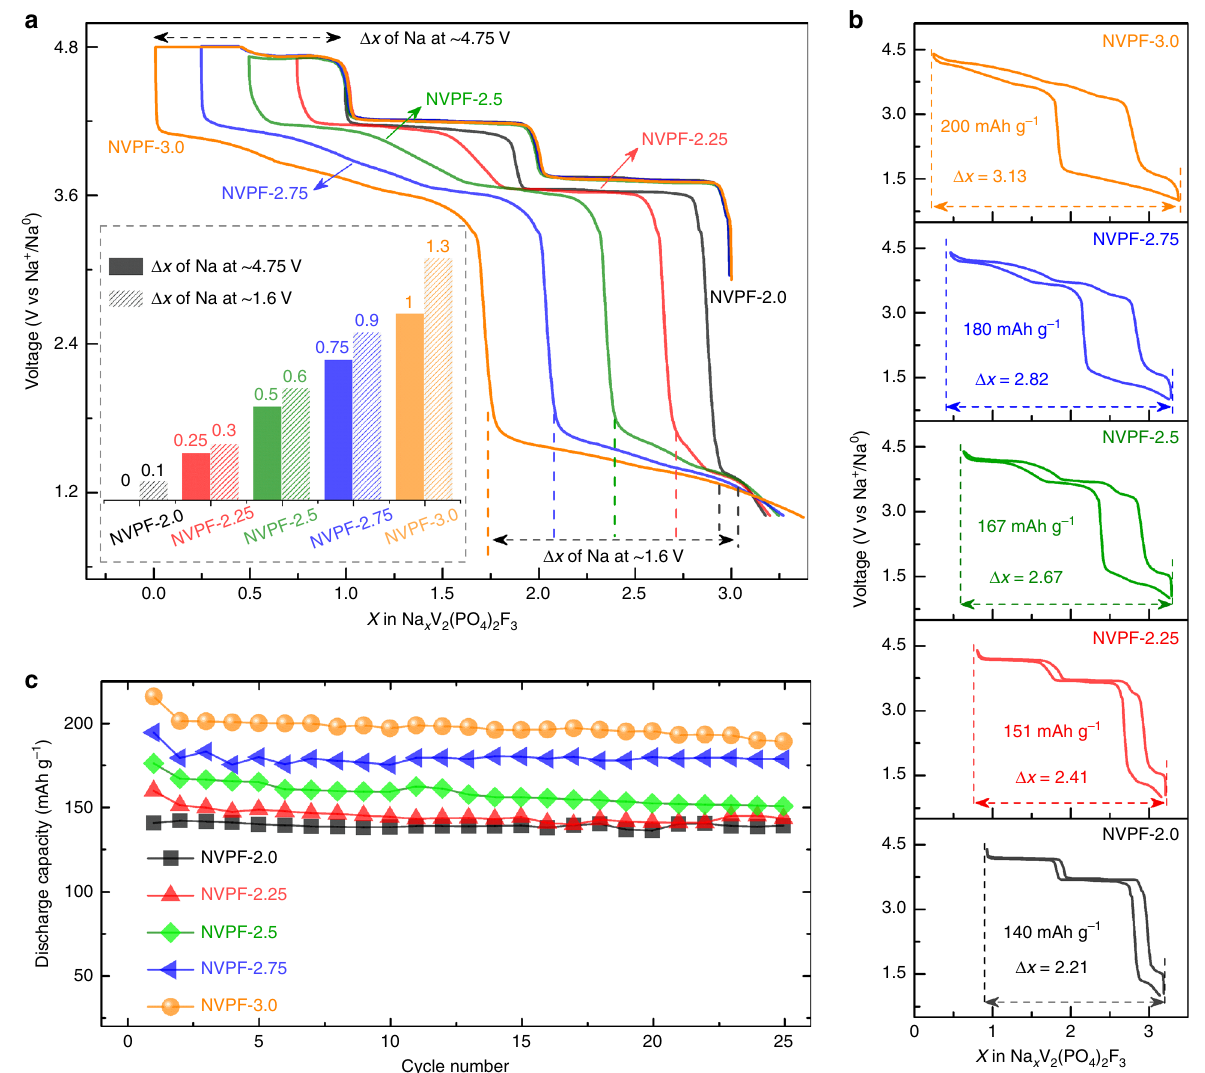
Fig. 2 Electrochemical characterization of NVPF samples in NVPF/Na half cells cycled between 4.4 and 1.0 V. a First cycle activation in which the charging potential is used up to 4.8 V and charge process controlled by limiting the Δ x (Na) = 2.0, 2.25, 2.50, 2.75, and 3.0 extracted, followed by discharge to 1 V at C/10. The inset shows the amount of Na + extracted at ~4.75 V and reinserted at ~1.6 V. b The charge-discharge pro fi le of the subsequent second cycle in the voltage window of 4.4 and 1.0 V. c The corresponding capacity retention